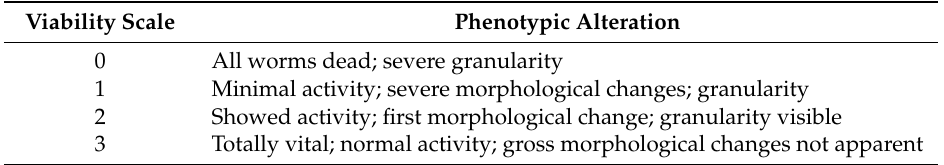
Table 1. Semi-quantitative viability scale used to evaluate phenotypic changes of Schistosoma mansoni newly transformed schistosomula (NTS) induced by compounds alone and its combinations